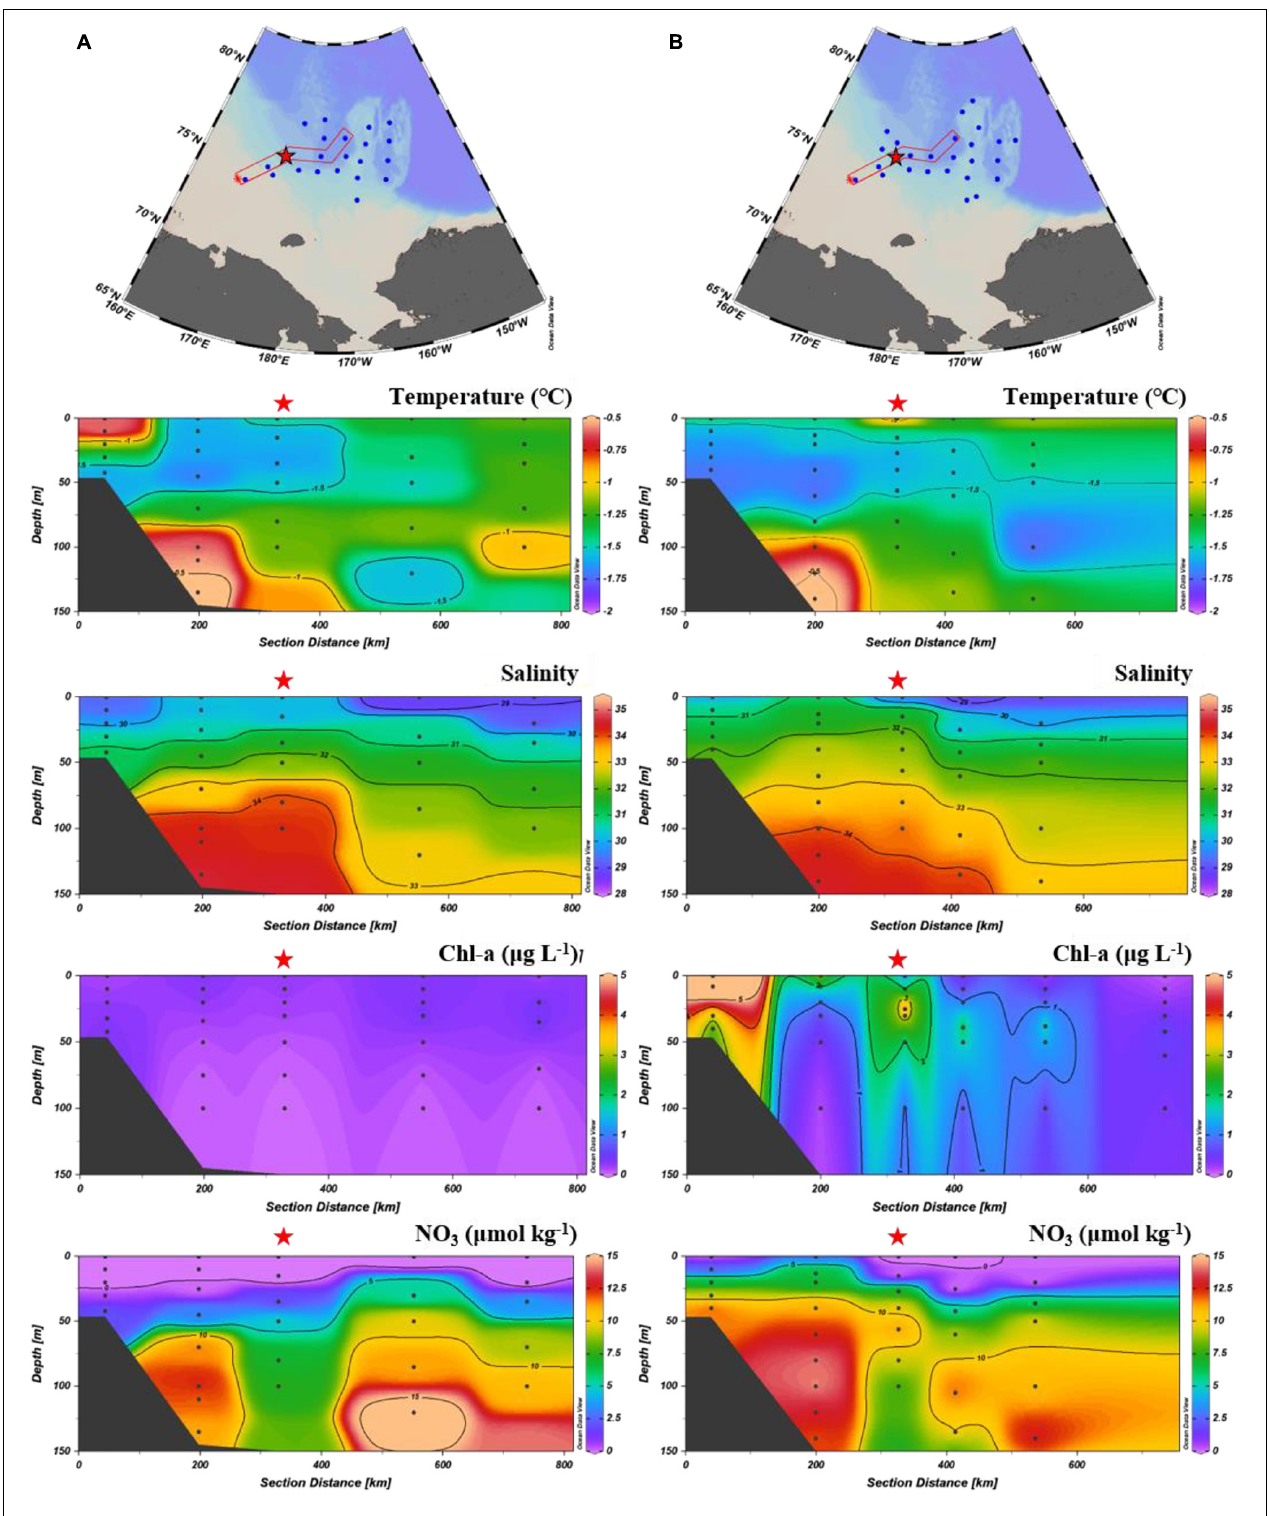
FIGURE 4 | Vertical distribution of temperature, salinity, chlorophyll- a , and nitrate along the transect on the East Siberian Sea slope (KAMS 1) in August 2017 (A) and August 2018 (B) . Red star indicates a sediment trap mooring site.